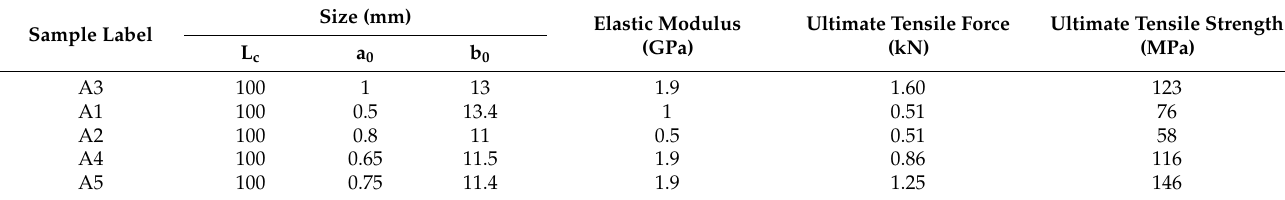
Table 2. Mechanical properties of the PP bands.